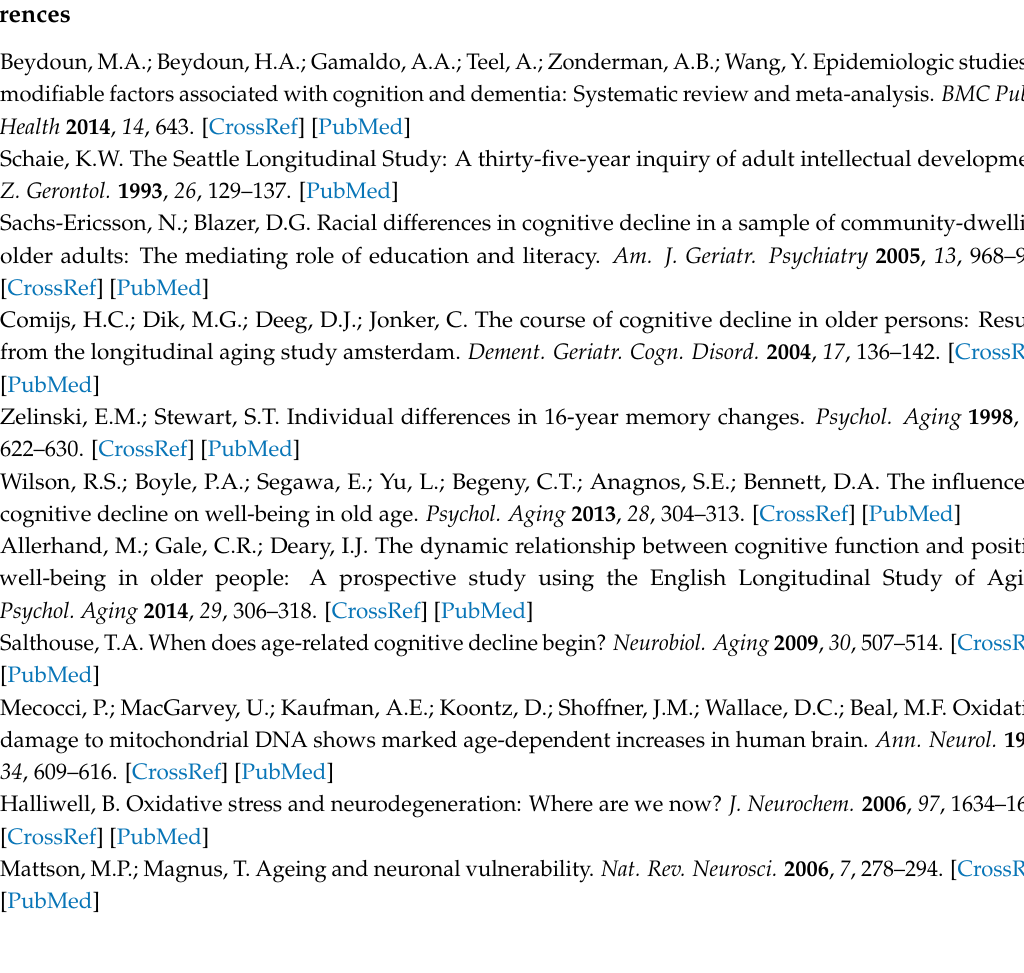
Table S1: Energy adjusted diet composition of study participants by milk intake group, mean (SE). ARIC Study, Table S2: Change in global z score by follow-up time period. ARIC Study, Table S3: Mean intake of milk and other dairy products by milk intake group. ARIC Study, Table S4: Distribution of milk intake groups and other dairy intake by total dairy intake quartiles. ARIC Study. Table S5. Estimated, adjusted * difference in the 20-year cognitive change by type of dairy intake. ARIC